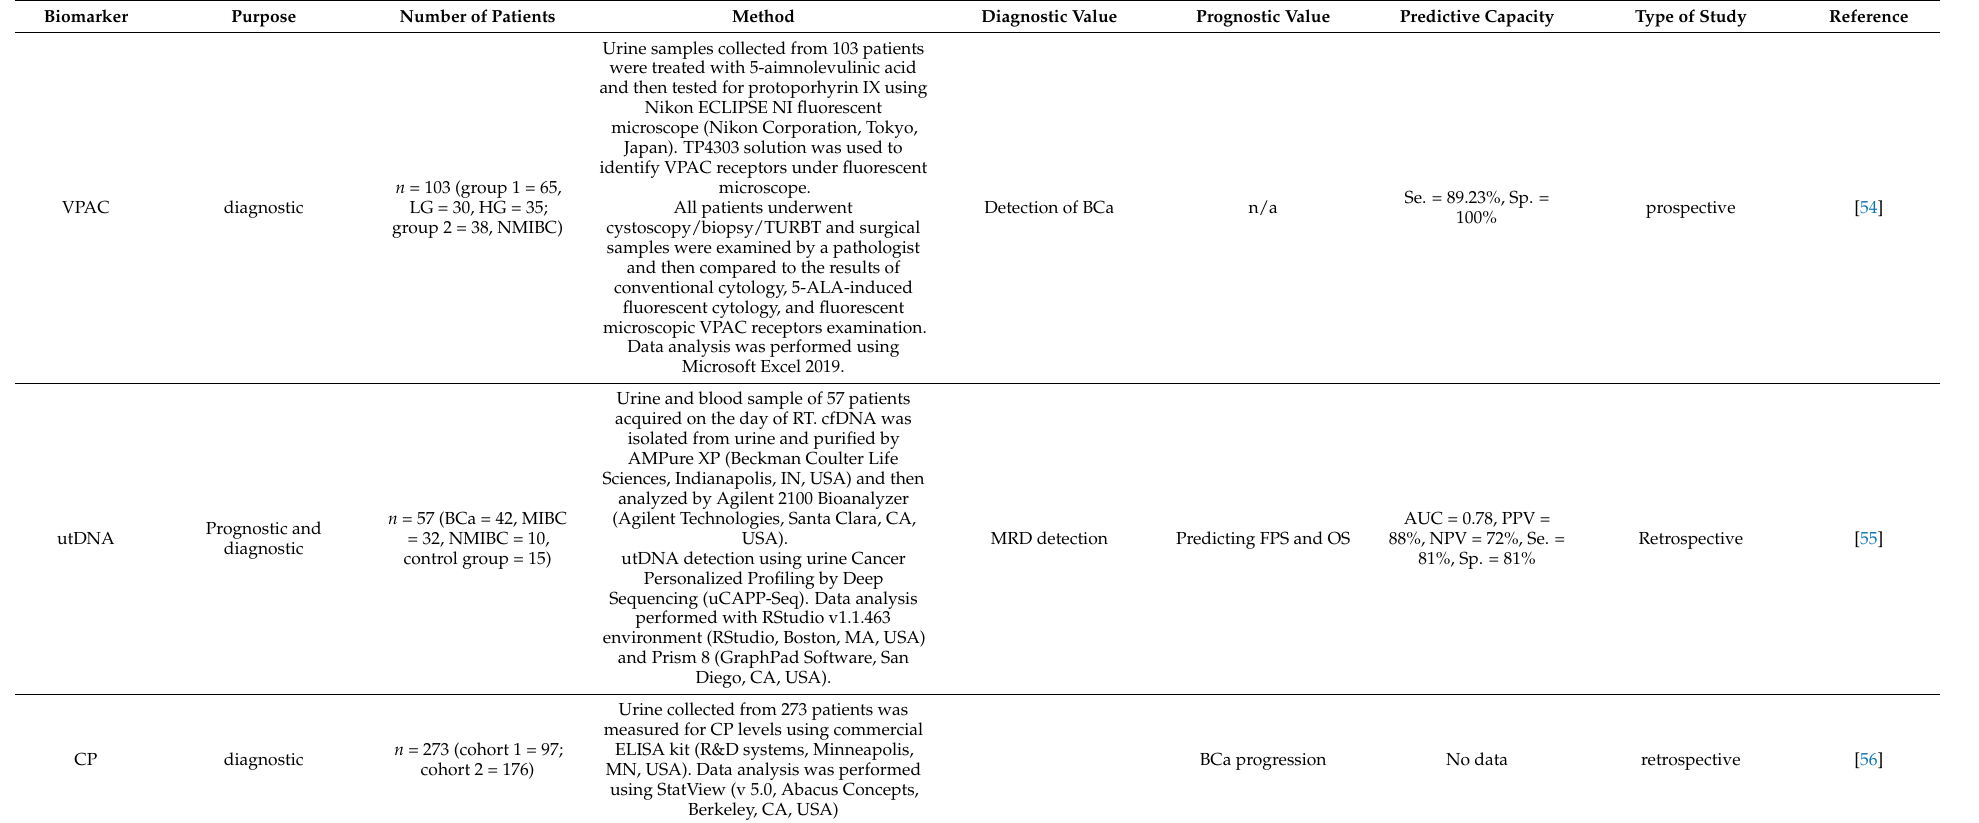
Table 7. Table presenting data for others